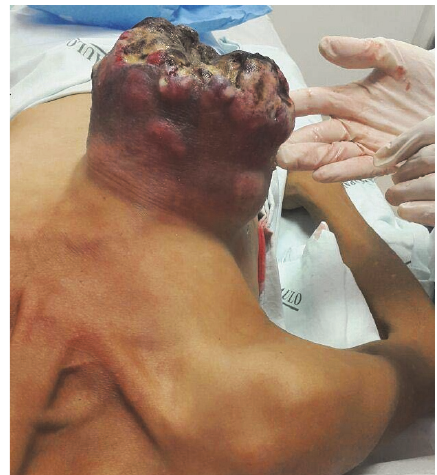
Figure 1: Aspect of the lesion in the admission of the patient.